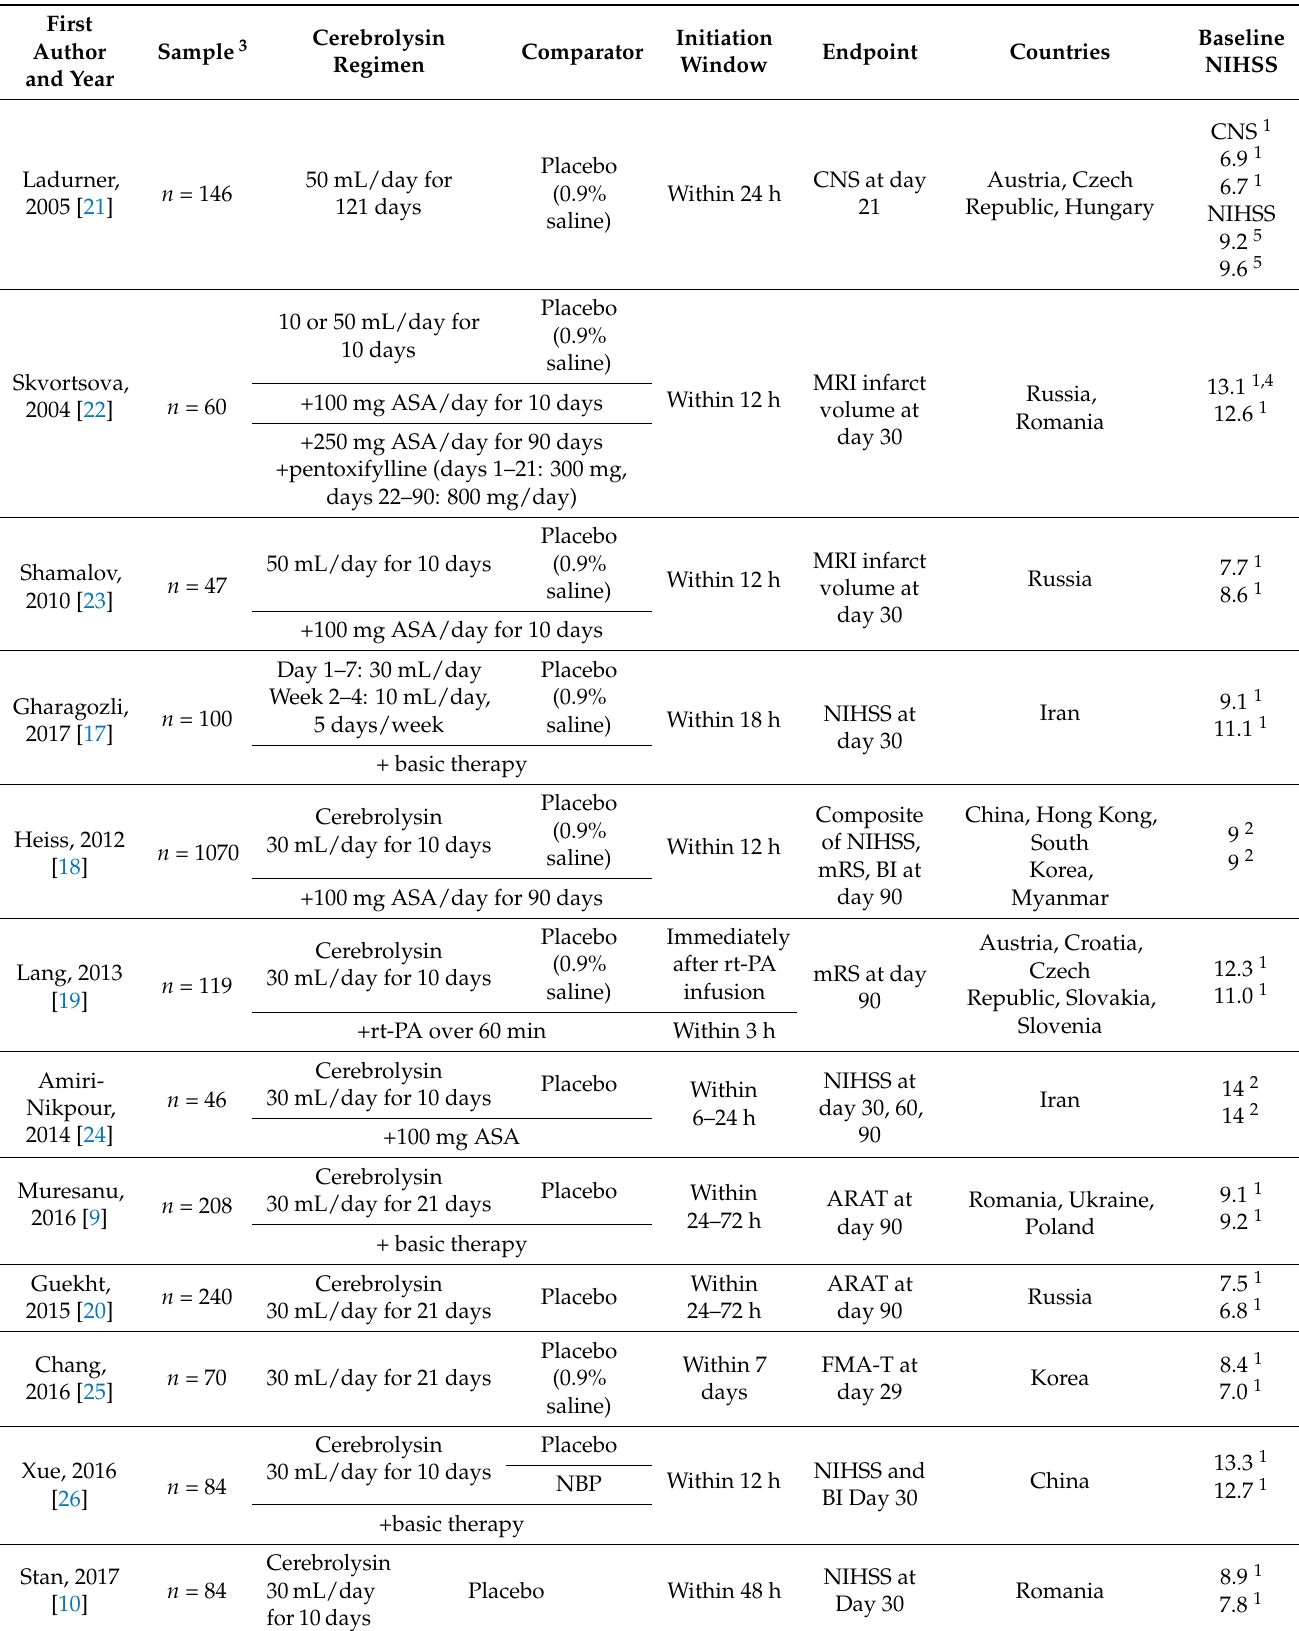
Table 1. Description of studies and populations included in formal